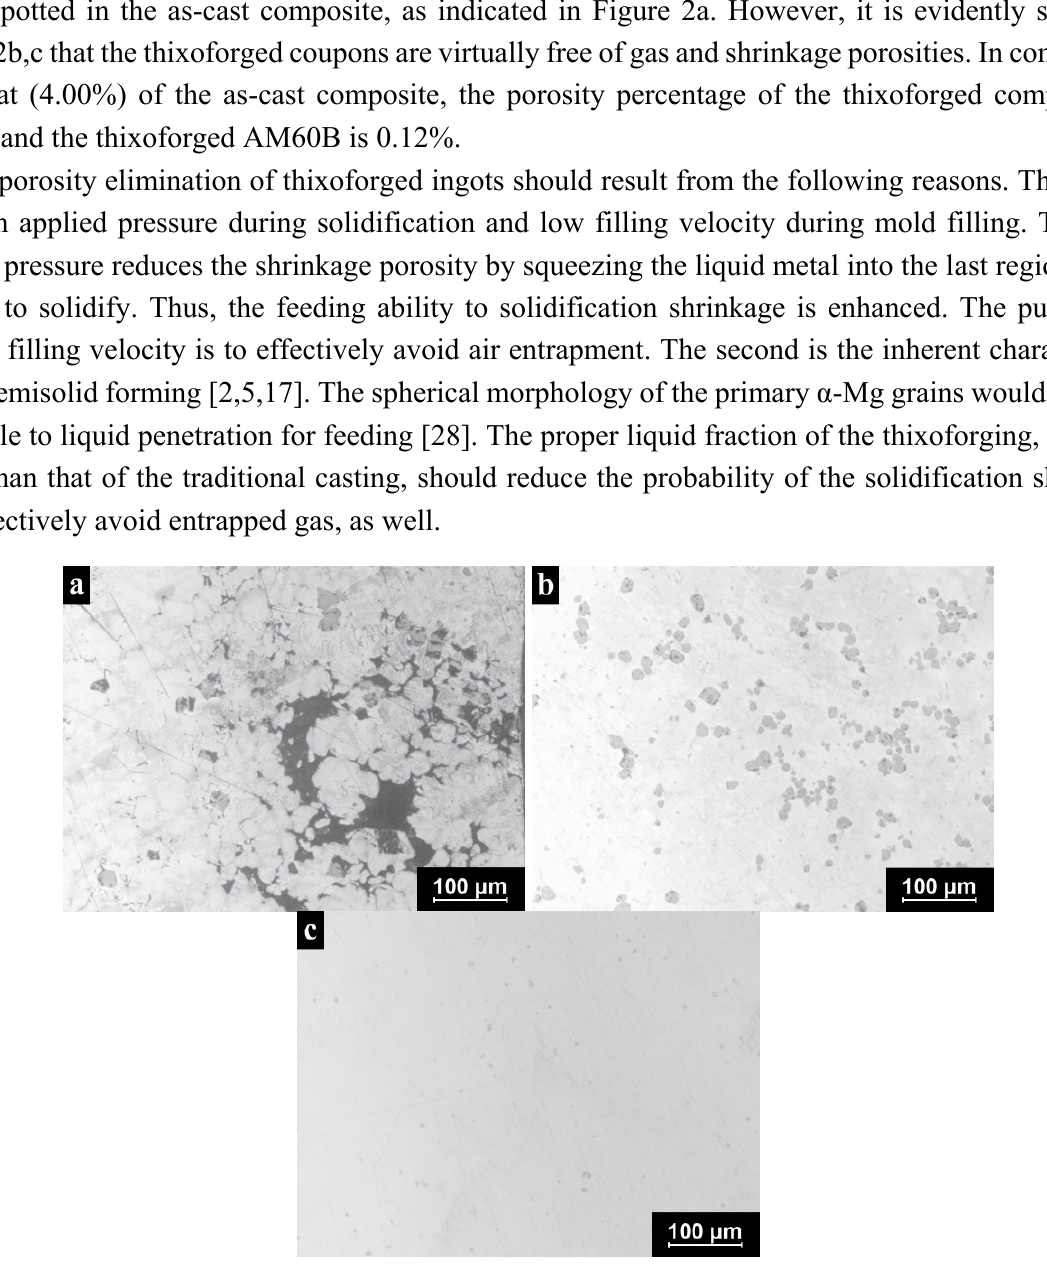
Figure 2. Optical micrographs showing porosity in: ( a ) as-cast composite; ( b ) thixoforged composite; and ( c ) thixoforged